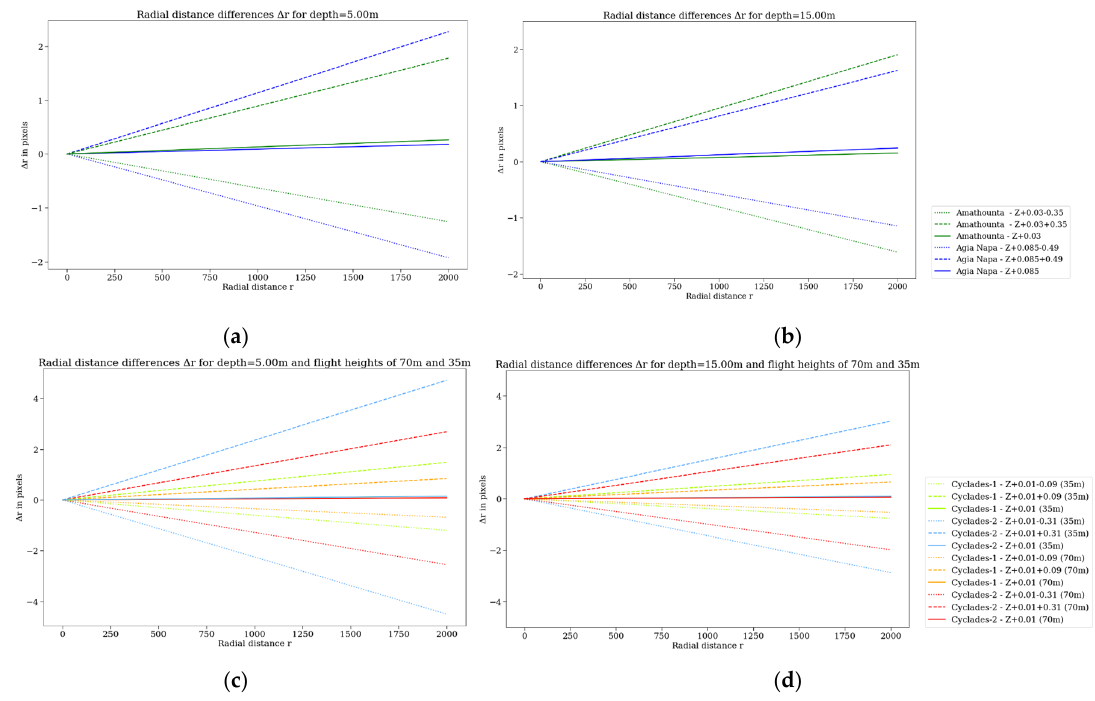
Figure 12. The radial distance differences for Amathounta and Agia Napa test sites are presented in ( a ) and ( b ) for depths of 5 m and 15 m respectively and the radial distance differences for Cyclades-1 and Cyclades-2 test sites are presented in ( c ) and ( d ) for depths of 5 m and 15 m respectively.